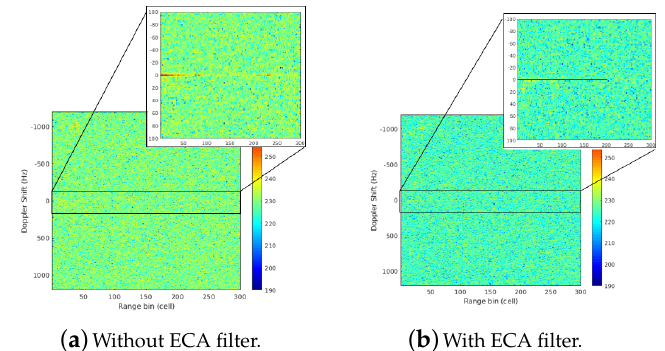
Figure 13. Single element CAF of CPI